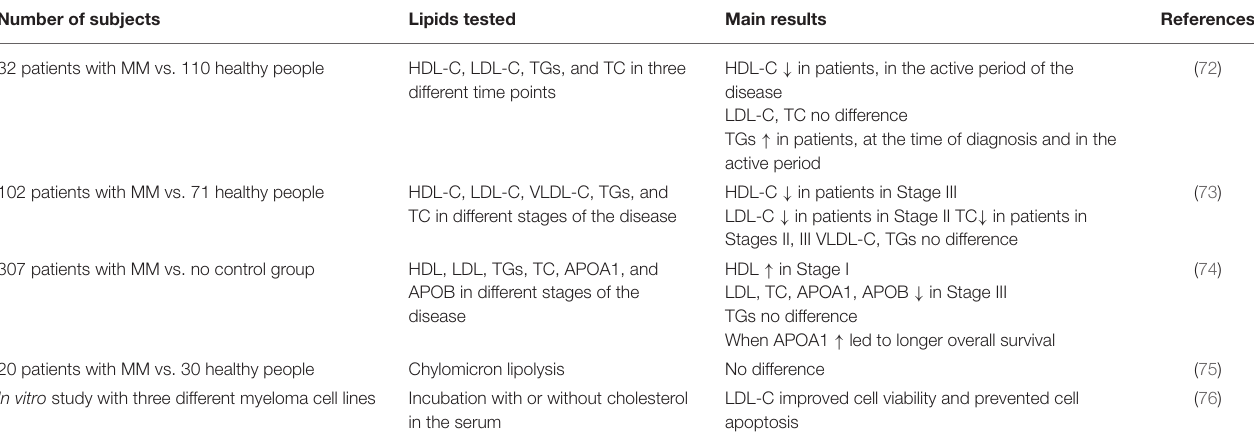
TABLE 1 | Clinical studies evaluating the changes in plasma HDL-Cholesterol (HDL-C), LDL-Cholesterol (LDL-C), Triglycerides (TGs), and Total Cholesterol (TC) levels in patients with multiple myeloma (MM). Number of subjects Lipids